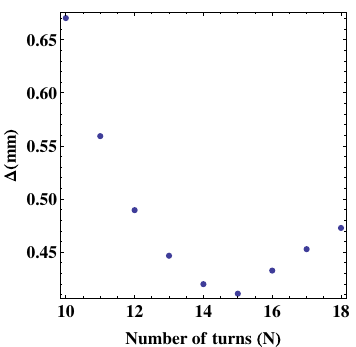
FIG. 11. Convergence of experimental